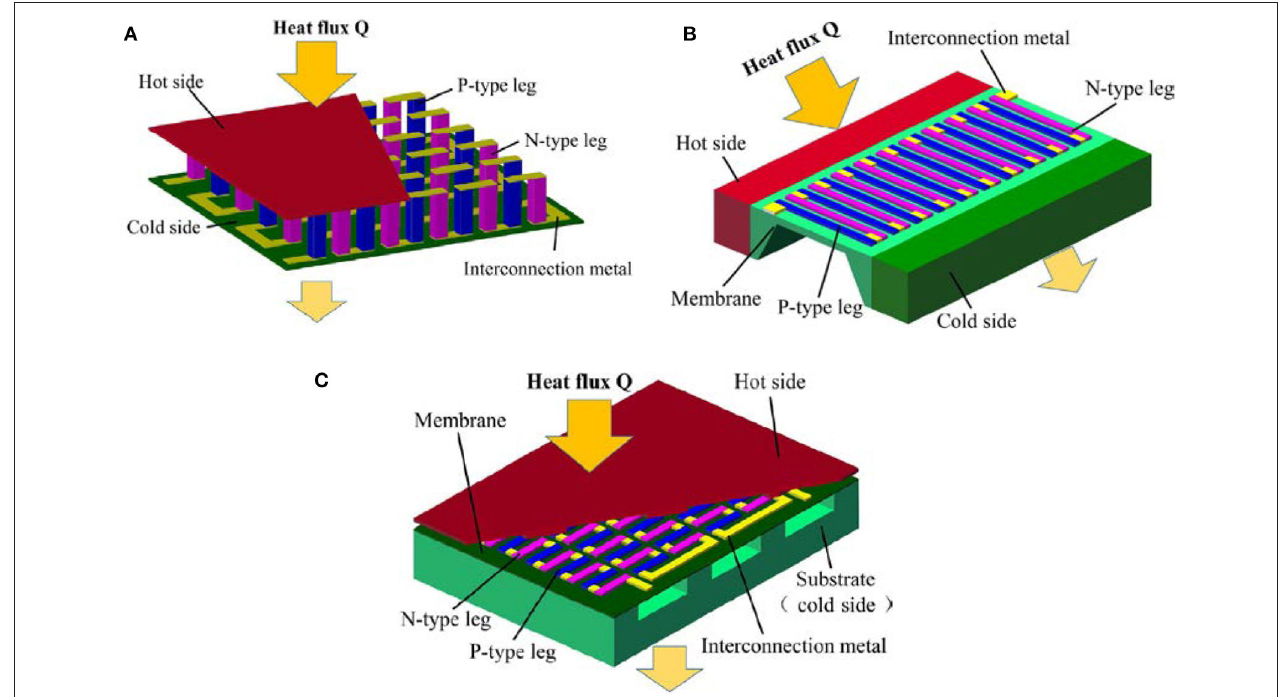
FIGURE 14 | Three types of µ TEG. (A) Vertical structure; (B) lateral structure; (C) hybrid structure. Reprint with permission from Yan et al.